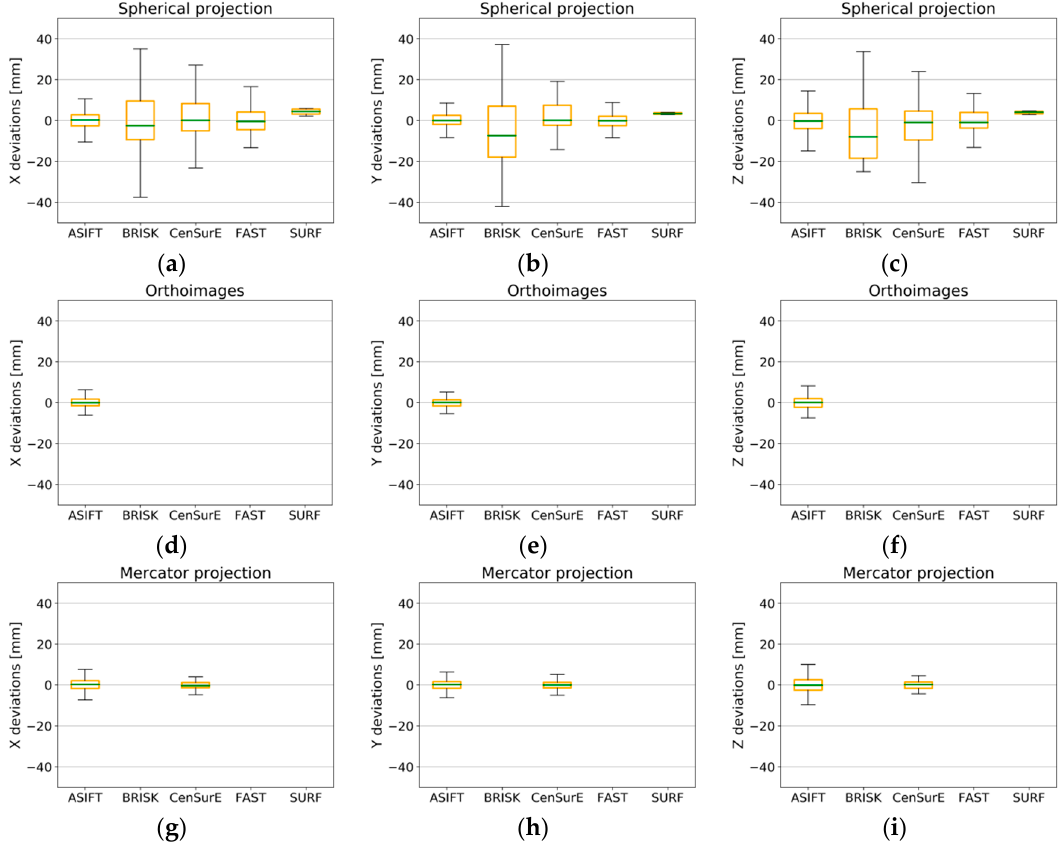
Figure 18. Box plots for the distribution of the deviations of natural control points for all pairs of fully registered scans (without points used for the ICP and non-registration) for Test Site IV. The spherical projection: component—x ( a ), y ( b ), and z ( c ); orthoimages: component—x ( d ), y ( e ), and z ( f ); the Mercator projection: component—x ( g ), y ( h ), and z ( i ).